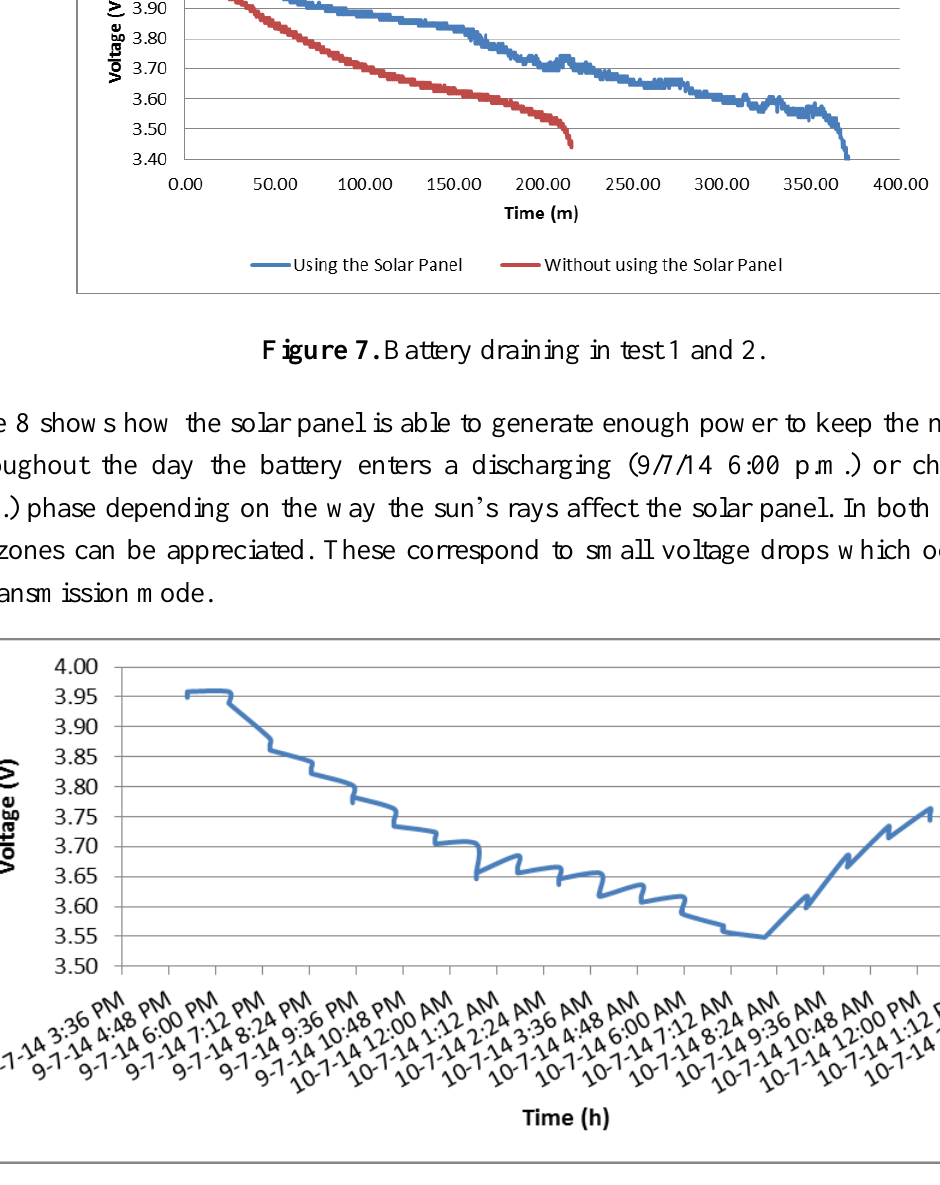
Figure 8. Battery charging/discharging in test